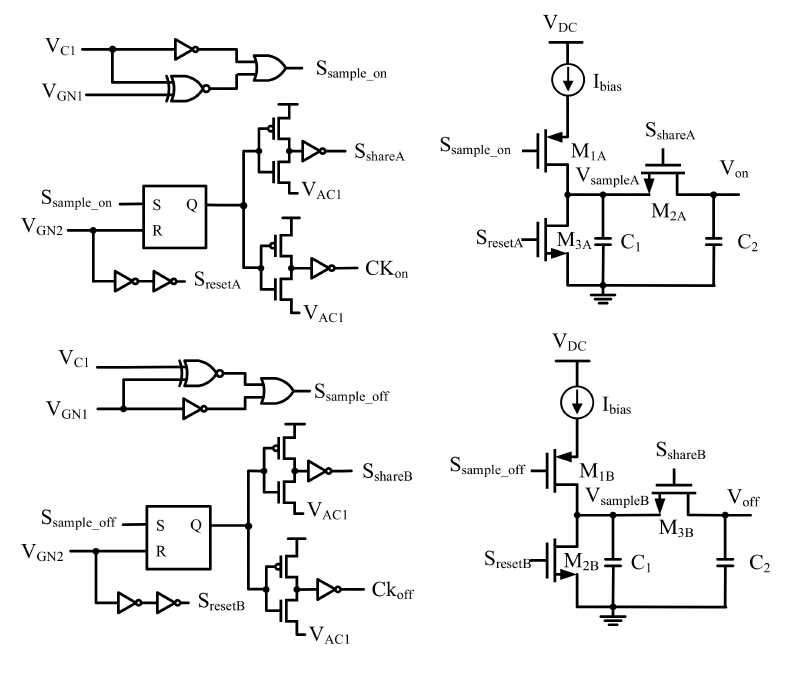
Figure 4. Phase error detector.